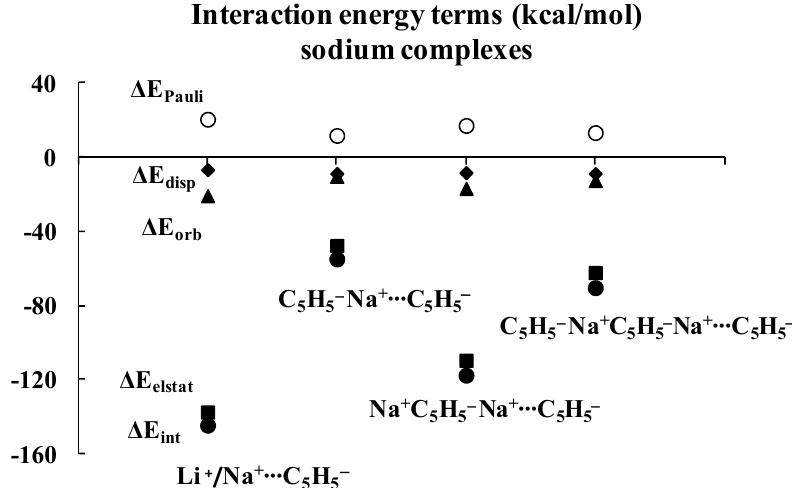
Figure 4. Energies of interactions (and their components according to Equation (1), all in kcal/mol) of a few complexes analyzed here; this figure presents the influence of the extension of the whole sodium system on these energies.